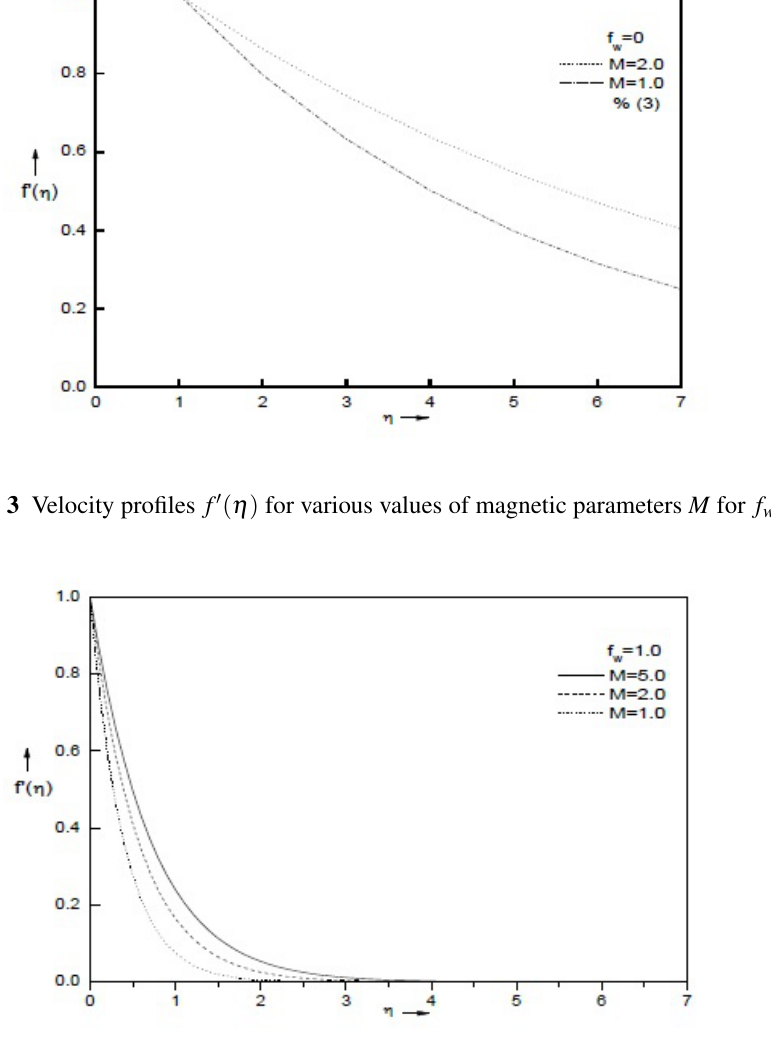
Fig. 4 Velocity profiles f (cid:48) ( η ) for various values of magnetic parameters M for f w = 1 .